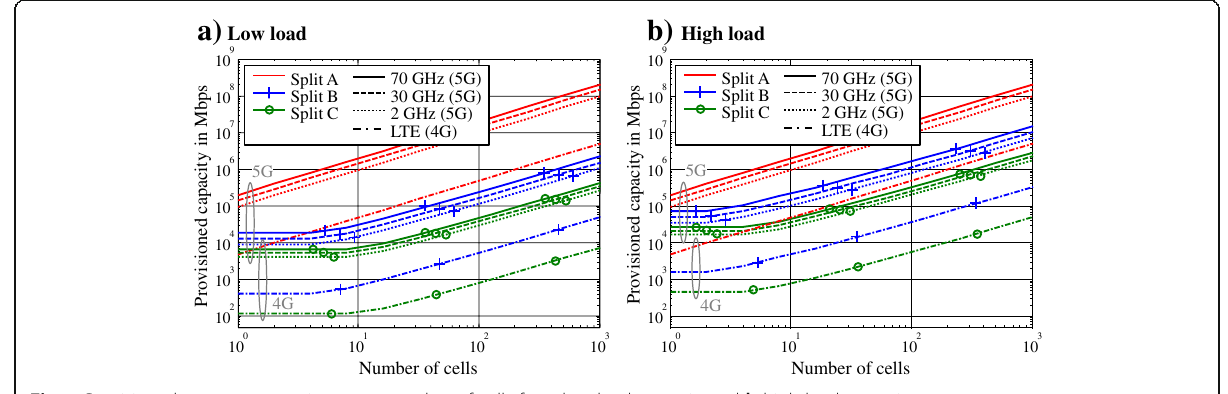
Fig. 7 Provisioned transport capacity versus number of cells for a low-load scenario and b high-load scenario